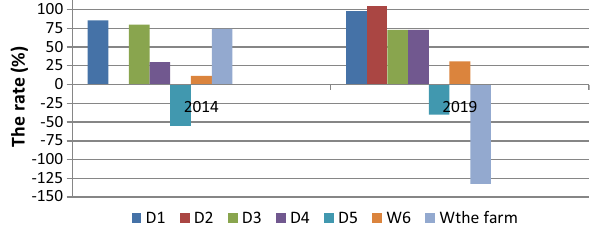
Fig. 11 The rate of change in Na + between 2014 and